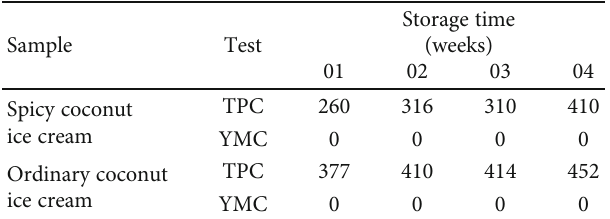
Table 4: Changes in microbial counts of spicy coconut ice cream and normal coconut ice cream during